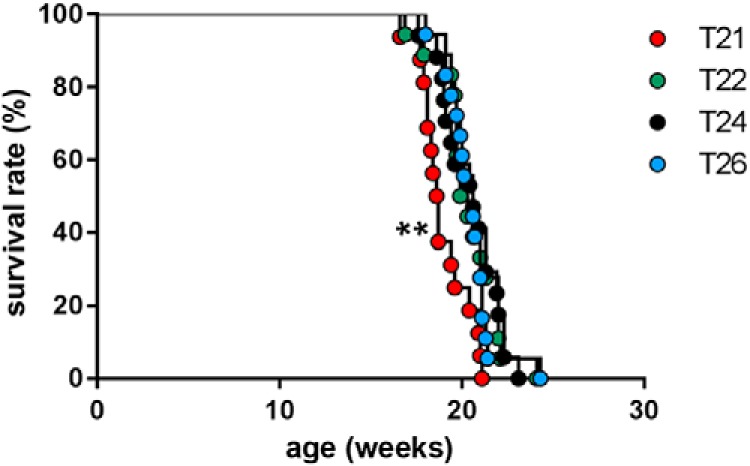
Survival of R6/2 mice exposed to different period lengths. Kaplan–Meier survival curves are shown for R6/2 mice placed under T24 (black symbols), T21 (red symbols), T22 (green symbols), and T26 (blue symbols). Survival was significantly different between mice placed under T21 compared with each of the other T-cycles tested (Log-rank Mantel–Cox test, p < 0.01). No significant difference in survival was seen among T22, T24, and T26. **p < 0.01.